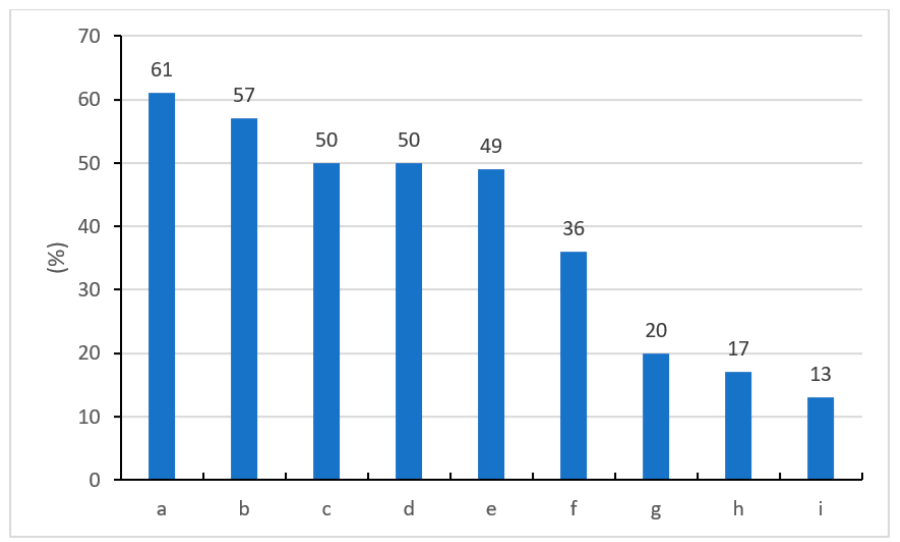
Figure 4. EU perception.